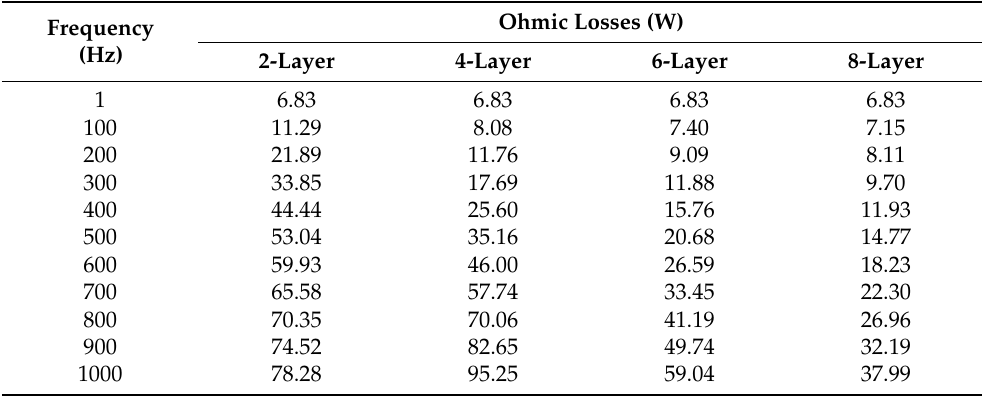
Figure 7. Comparison of numerical results of current density distribution counter plot at 1 kHz: ( a ) four-layer, ( b ) eight-layer layout, and ( c ) diagram current density distribution diagram of both layouts. Table 3. Ohmic losses of various